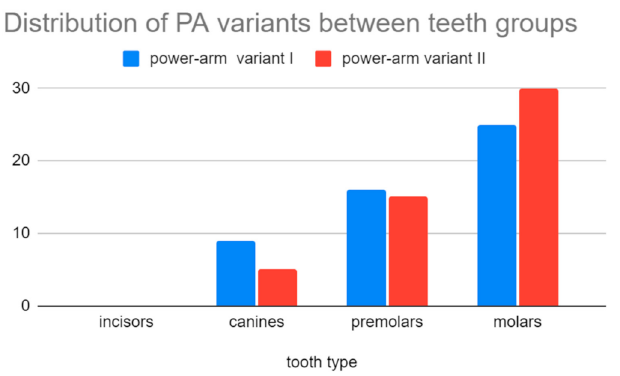
Figure 16. Chart shows no significant imbalance in the random distribution of both power-arm designs between main types of teeth. The distribution is balanced.